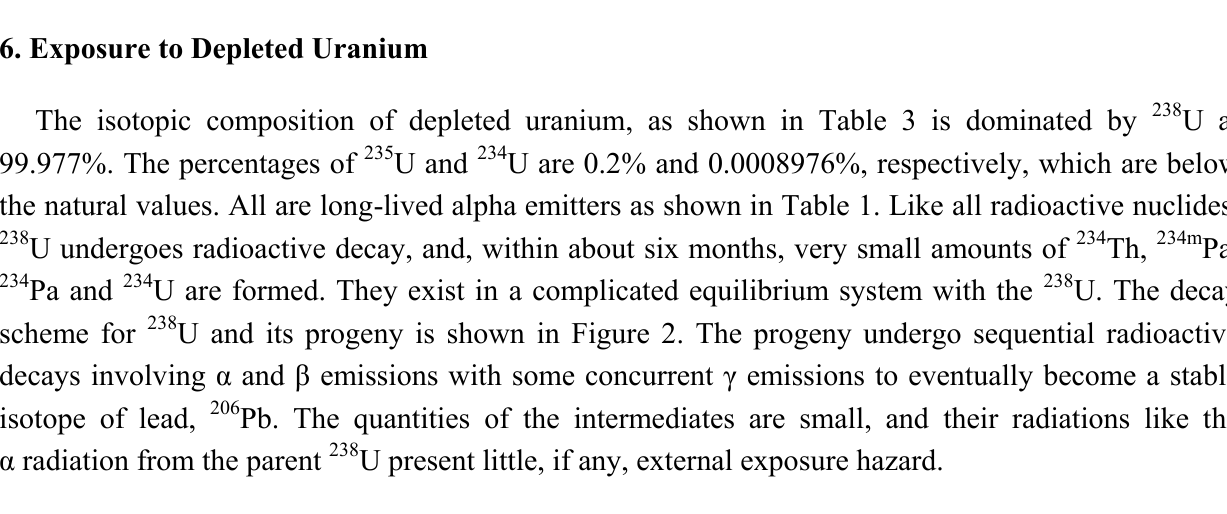
Figure 2. Decay chain for